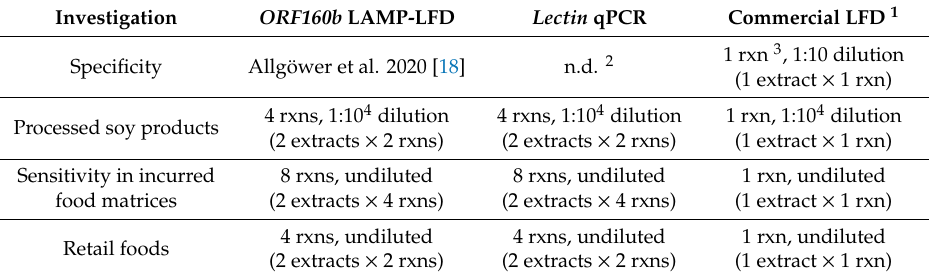
Table 1. Number of replicate analysis according to type of investigation and method